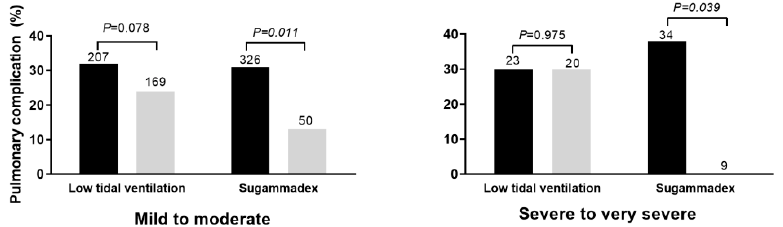
Figure 3. Respective impact of low tidal volume ventilation and sugammadex use according to airflow limitation degree. The gray bar indicates the patients with low tidal volume ventilation or sugammadex use. The number above the bar indicates the total number of patients within the subgroup.